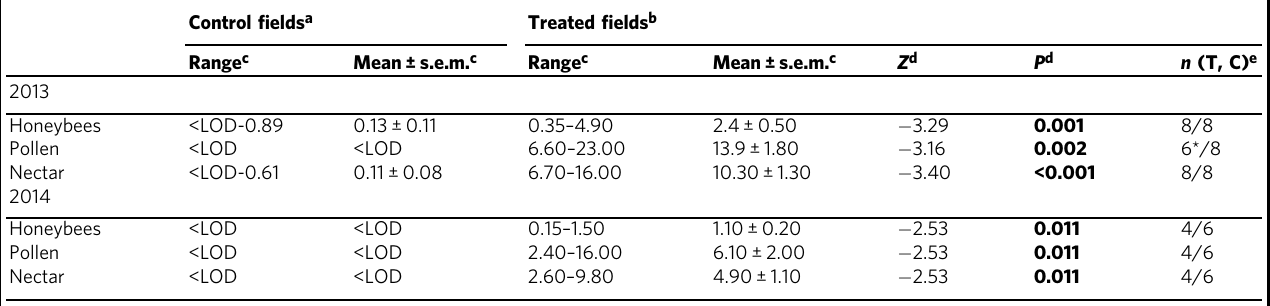
Table 1 Clothianidin residues in honeybees, pollen and nectar during 2013 –